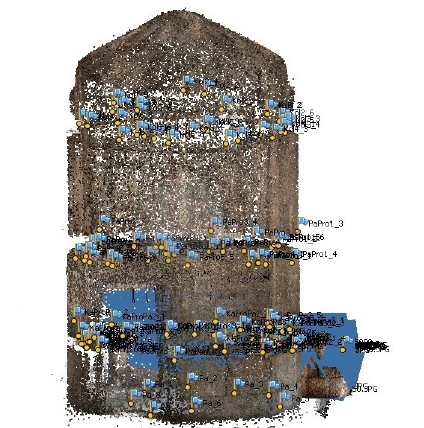
Figure 10: The sparse point cloud of the interior of the Tower of the